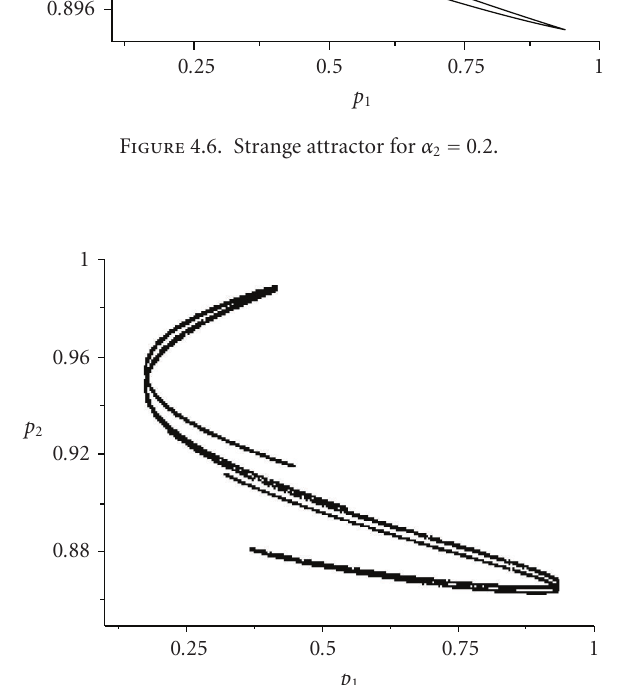
Figure 4.7 . Strange attractor for α 2 = 0 .